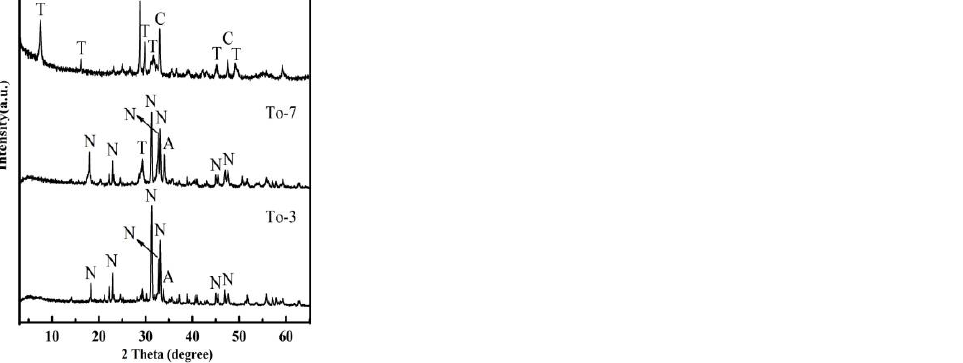
Figure 3. XRD pattern of products synthesized at different temperatures for 12 h. N—NaCaHSiO 4 ; A—Ca(OH) 2 ; T—11Å-TA; C—Ca 3 Al 2 O 6.